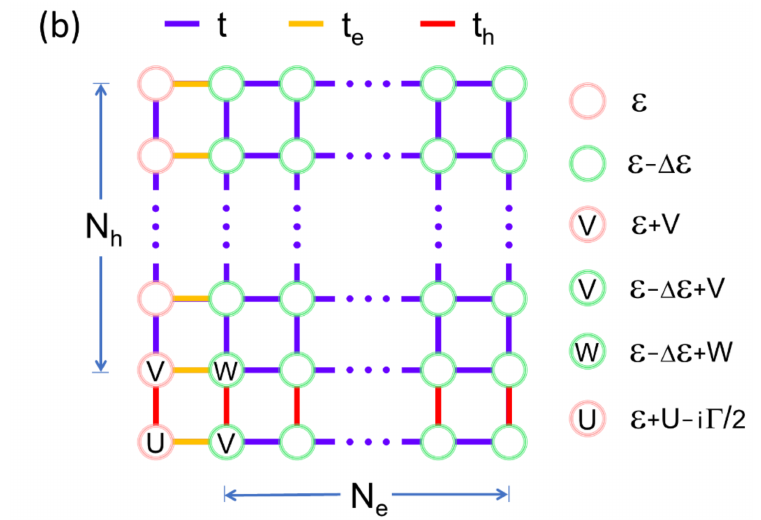
Figure 1. (Color online) ( a ) Schematic representation of a donor-acceptor interface, whose photocell has connections to two leads of N e coarse-grained molecules for electrons and of N h ones for holes. ( b ) The square lattice of excitonic states originated from a Hamiltonian (1) with local (U) and non-local (V, W) electron-hole interactions represented by impurity